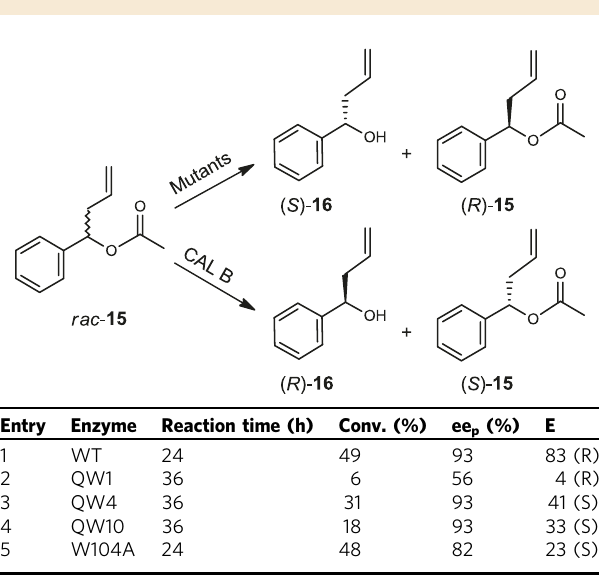
Table 2 Stereoselectivity of hydrolytic kinetic resolution of rac -15